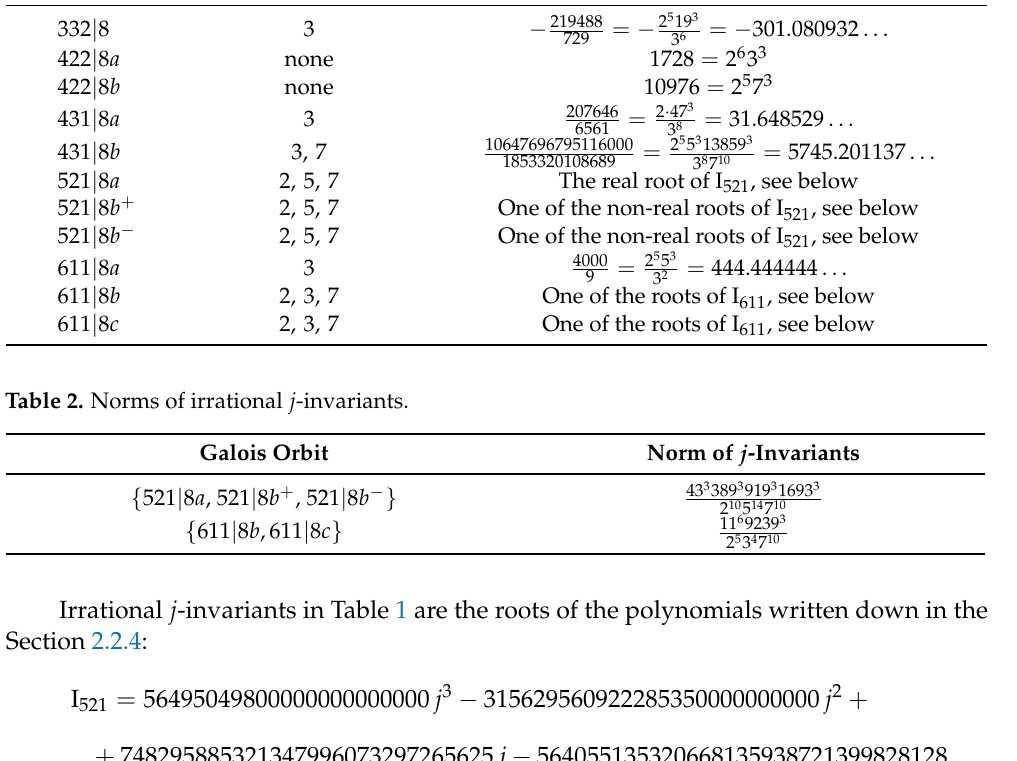
= − 2 5 19 3 = − 301.080932 . . . 729 3 6 10976 = 2 5 7 3 10647696795116000 = 2 5 5 3 13859 3 = 5745.201137 . . . 1853320108689 3 8 7 10